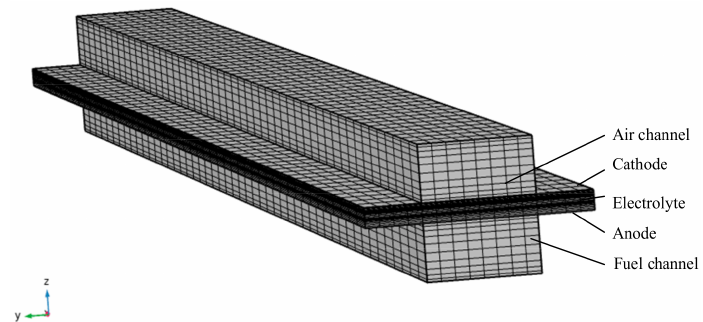
Figure 3. Numerical model without the